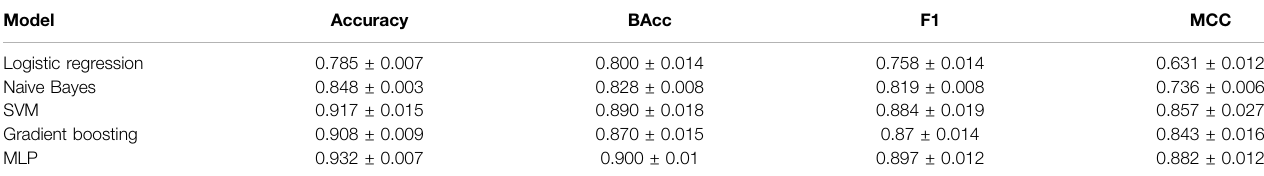
TABLE3| Resultsfortheclassi fi cationofcomplexesonprincipalcomponents.Foreachmetric,the fi rstcolumnistheaverageovertheresults10runsofthecross-validation, while the second column is the standard deviation of these results.